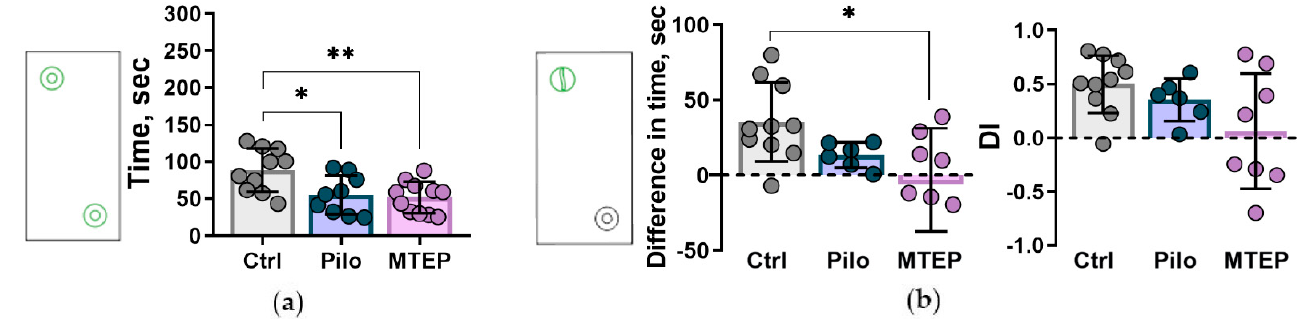
Figure 12. Exploratory behavior and memory characteristics in the novel object recognition test. ( a ) The novel objects interaction paradigm: chart shows time spent interacting with identical objects. * p < 0.05, ** p < 0.01 in one-way ANOVA with Tukey’s post hoc test, F 2,27 = 6.4, p = 0.005. ( b ) Novel object recognition: the left chart shows the difference in time spent on interaction with novel object versus familiar object, the right chart shows discrimination index (DI) for which +1 indicates a preference of the novel object, − 1 indicates a preference of the familiar object, and 0 indicates no preferences. * p < 0.05 in one-way ANOVA with Tukey’s post hoc test, F 2,21 = 4.8, p = 0.02. On all charts, the circles show individual values. The columns indicate average values and error bars show standard deviations.